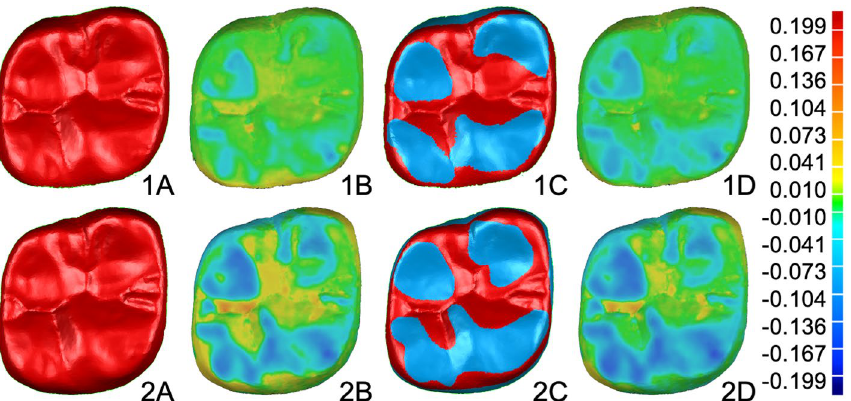
Figure 1. Color-coded superimposition procedure and the wear progression of first molar CAD/CAM composite restoration (Patient 6) in the first (1) and third (2) year. ( 1A / 2A ) pre-alignment over the full occlusal area; ( 1B / 2B ) differences between baseline and recall dataset after the pre-alignment; ( 1C / 2C ) iterative selection of areas, which were not exposed to wear, for further alignment of the data; ( 1D / 2D ) visualization of wear areas after the final data